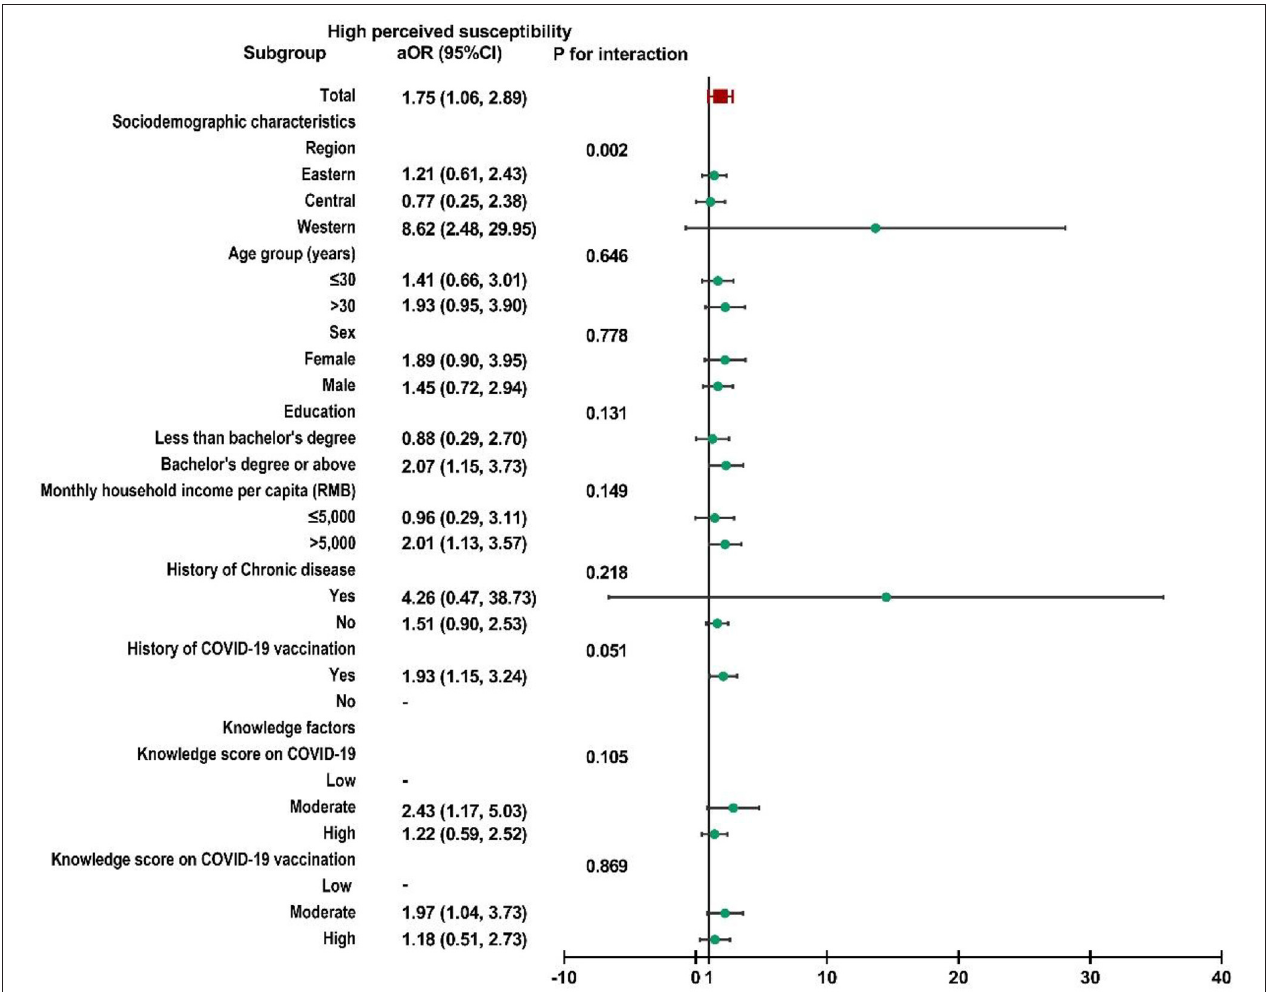
FIGURE 3 | Subgroup analysis of the association between risk perception and acceptance of a booster dose of COVID-19 vaccine to children among caregivers with high perceived susceptibility.